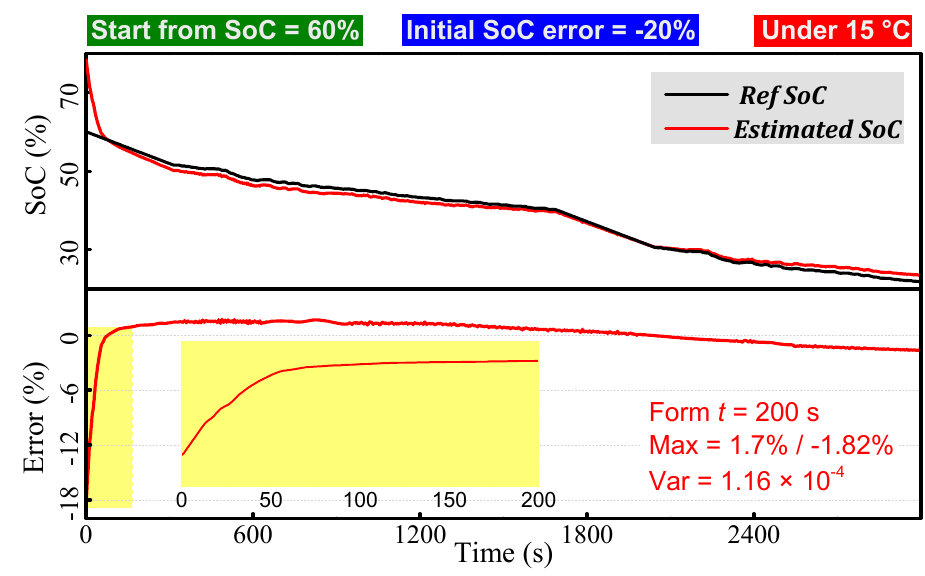
Figure 10. SoC estimation result with − 20% initial error under 15 °C.